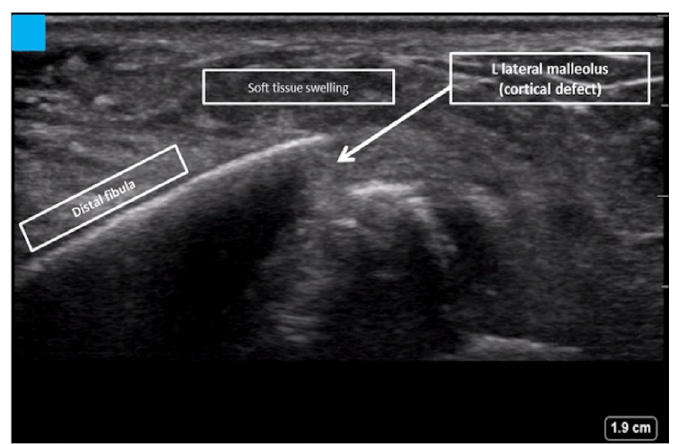
Image 1. Longitudinal point-of-care ultrasound image of the distal fibula demonstrating a cortical defect.